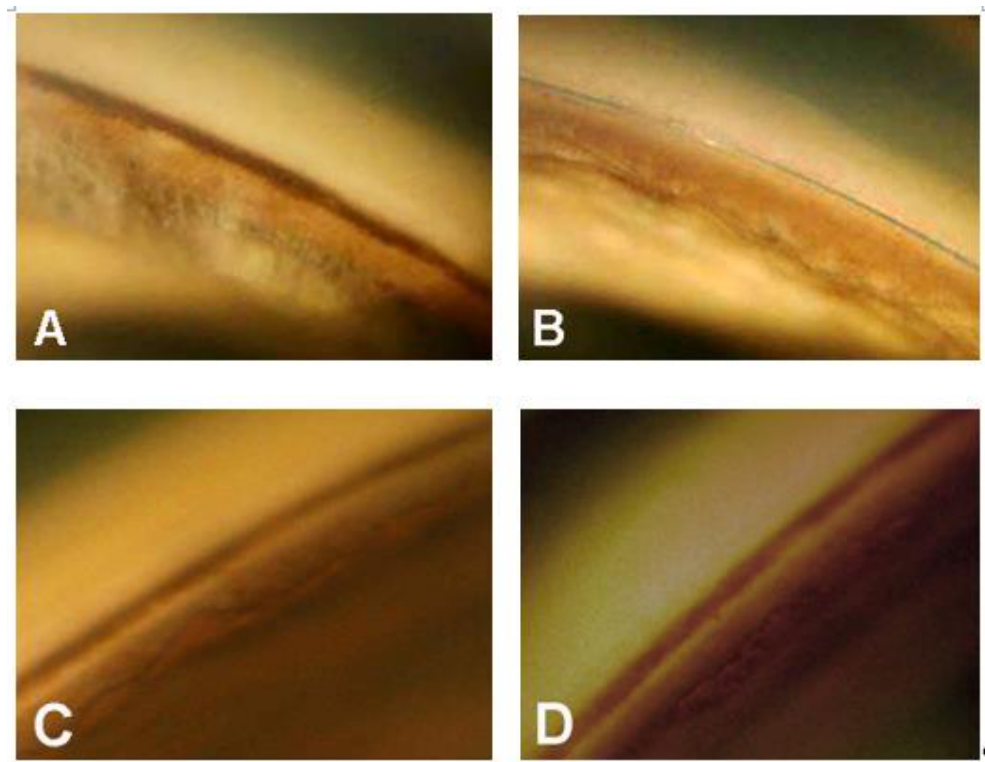
Figure 5. ( A ) Preoperative gonioscopic view of the trabecular meshwork in a 46-year-old man with pigmentary glaucoma; B and C significant reduction of trabecular pigment, one year ( B ) and two years ( C ) after canaloplasty; ( D ) almost complete reabsorption of trabecular pigment three years after surgery.